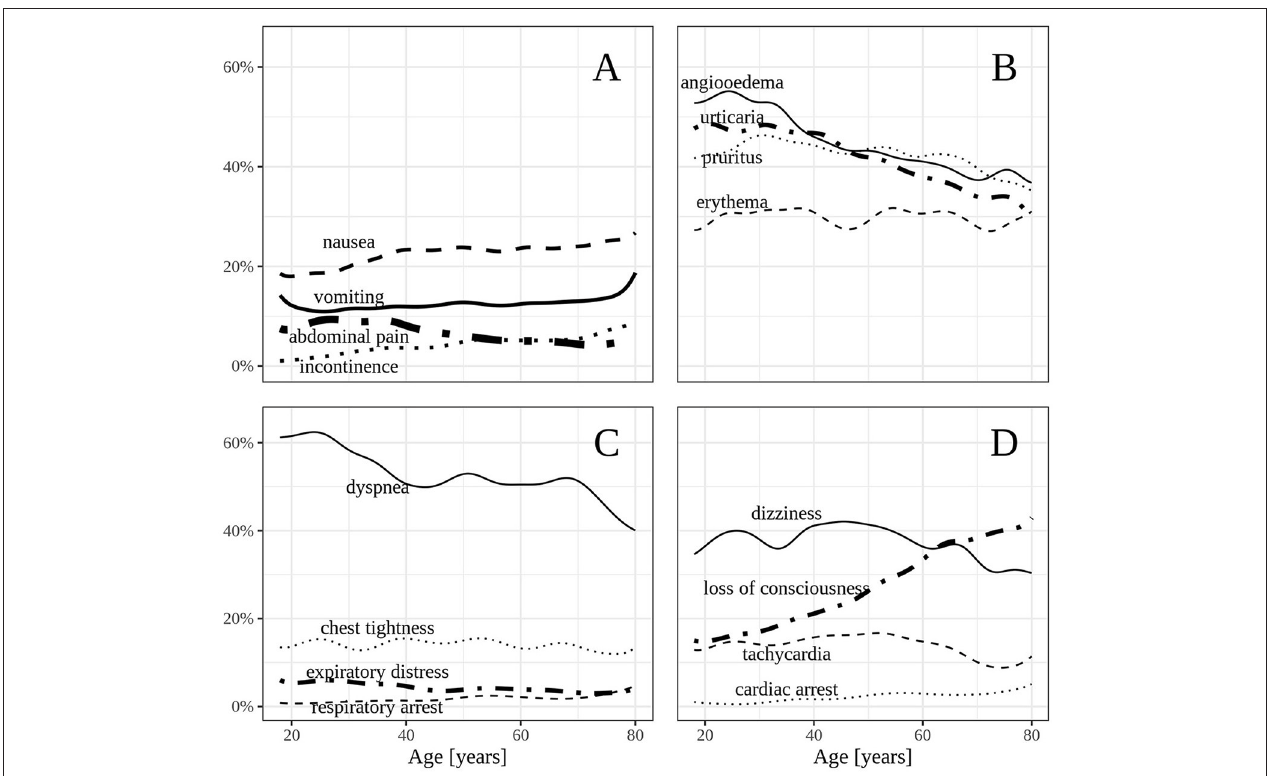
FIGURE 3 | (A–D) Frequency of selected symptoms according to age in adults.